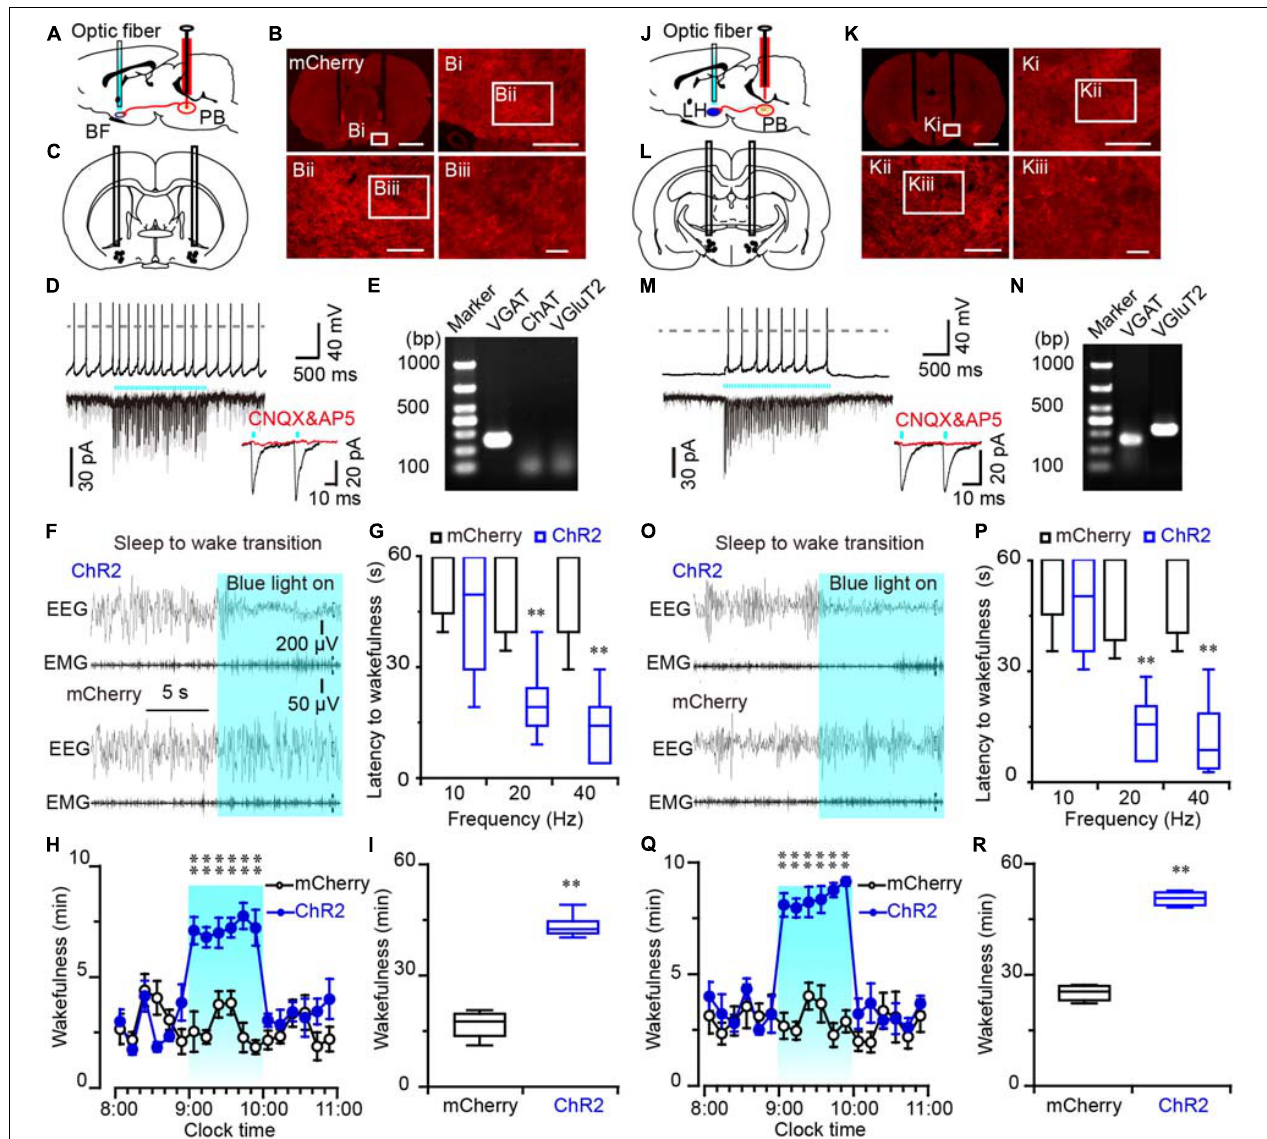
FIGURE 5 | Photostimulation of ChR2-expressing MPB axonal terminals in the BF or LH evoked waking response in rats. (A,J) Diagram depicting the location of the optic fiber in the BF (A) or LH (J) of a rat injected with AAV-CaMKII α -ChR2-mCherry or AAV-CaMKII α -mCherry in the MPB. (B,K) Coronal sections with native mCherry fluorescence confirmed the expression of ChR2 protein in the BF (B) or LH region (K) . Scale bars: B, K = 2 mm; Bi, Ki = 500 µ m; Bii, Kii = 200 µ m; Biii, Kiii = 50 µ m. (C,L) The schematic diagram showing the cannula traces and the optic fibers targeting the BF (C) or LH (L) . (D,M) Photostimulation of ChR2-expressing MPB axons increased firing frequency and evoked synchronized EPSCs in a BF (D) or LH neuron (M) ; the evoked EPSCs were blocked by CNQX and AP5 (red trains). (E,N) Single-cell RT-PCR analysis of ChR2-expressing neurons in BF (E) and LH (N) indicates the bands represent VGluT2 or VGAT, respectively. (F,O) EEG/EMG examples of sleep to wakefulness transition following optogenetic stimulation in the BF (F) or LH (O) of a rat with bilateral ChR2 (top) or mCherry (bottom) expression in the MPB, respectively. (G,P) Latency of sleep to wakefulness after optogenetic stimulation in the frequency range of 10–40 Hz in BF (G) or LH (P) . (H,I,Q,R) The time course (H,Q) and total amount (I,R) of wakefulness during optogenetic stimulation in BF and LH, respectively. ** P < 0.01 compared with mCherry groups ( n =